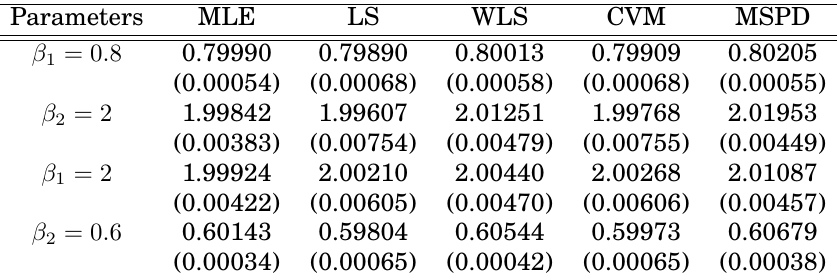
Table 4: AVs and MSEs for ς = 500